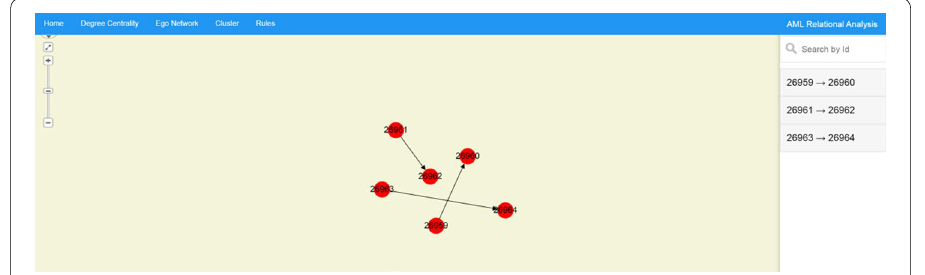
Fig. 12 Rule 4: Spouse relationship